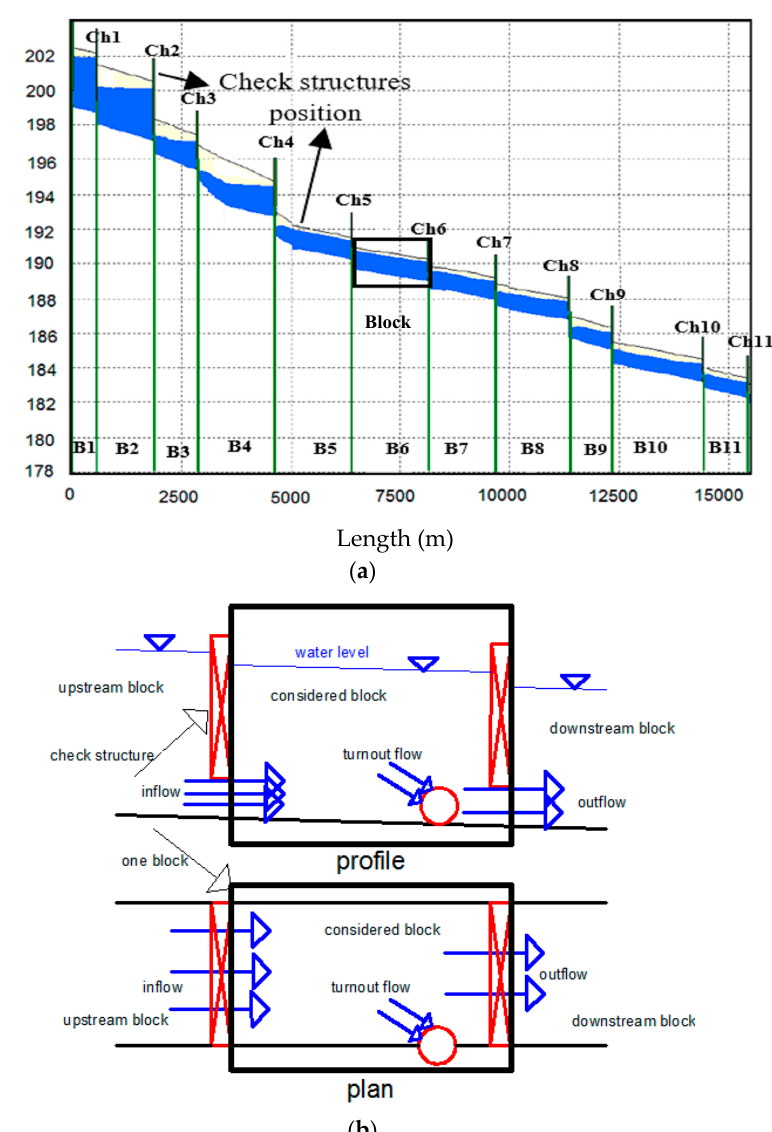
Figure 2. The East Aghili Canal layout: ( a ) canal profile; ( b ) profile and plan of a block (B6).